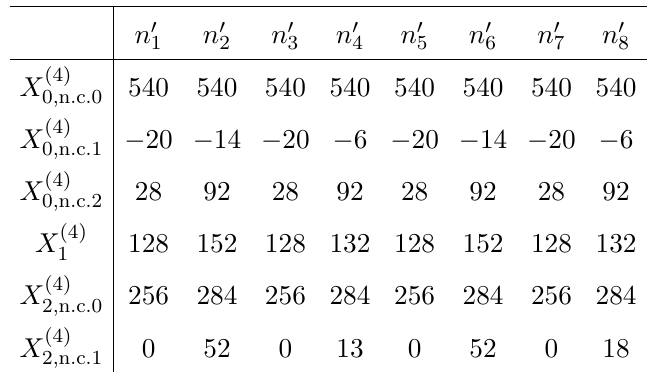
Table 13 . The coefficients of the base degree zero contributions to the genus zero free energies (7.11) for the fibrations in X ( X (4) ) and their non-commutative 0